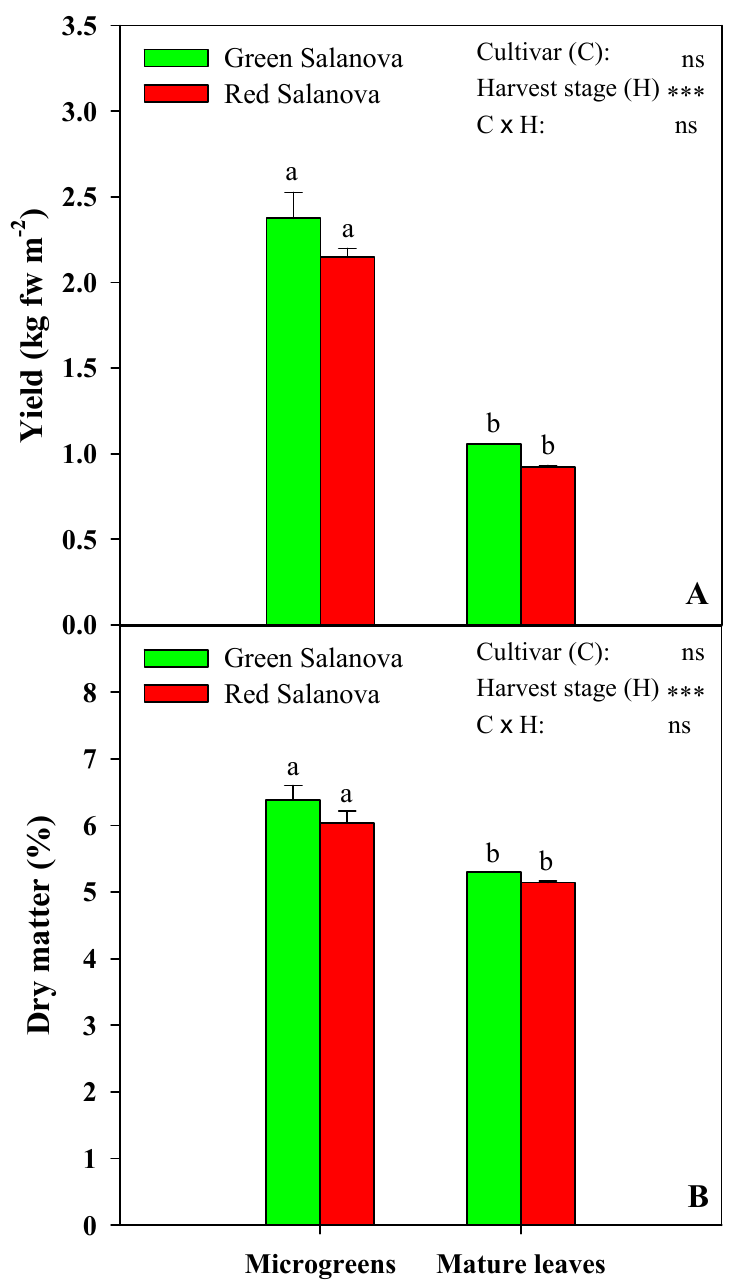
Figure 1. Yield ( A ) and dry matter ( B ) of green and red Salanova butterhead lettuce as dictated by different developmental stages of harvest maturity. ns, *** Non-significant or significant at p ≤ 0.001, respectively. Cultivar and harvest stage means were compared by t -test. Different letters indicate significant differences according to t -test ( p = 0.05). All data are expressed as mean ± standard error, n = 3.